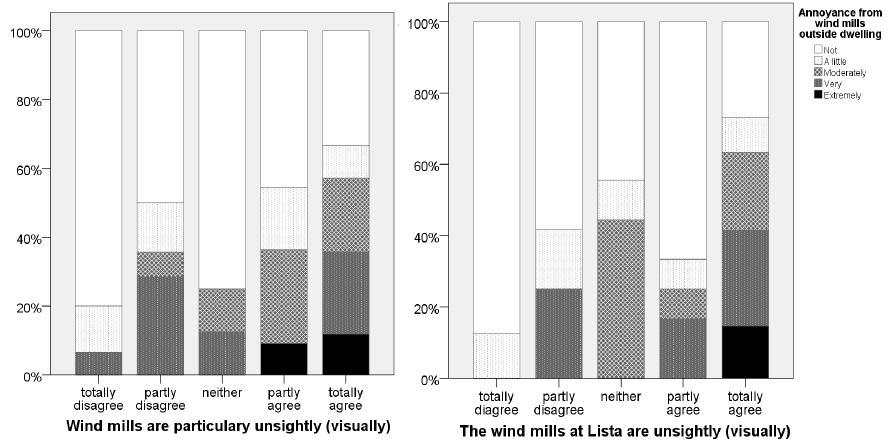
Figure 7. Level of agreement with the statement that windmills are a visual blight in general ( left panel ) and at Lista in particular ( right panel ). n = 90.